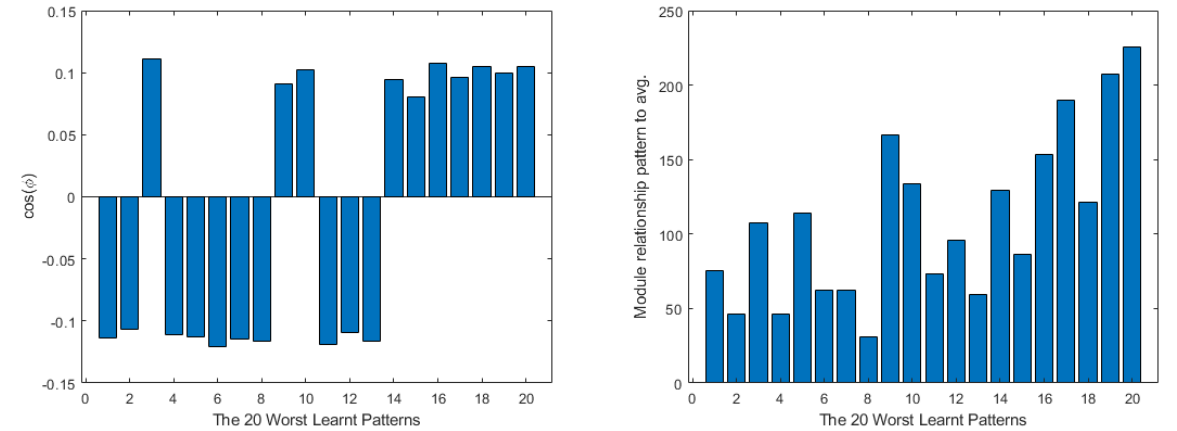
(cid:12) (cid:12) 𝜕𝐿𝑜𝑠𝑠 ∂ Loss (cid:12) (cid:12) | relationship to the average (cid:12) (cid:12) relationship to the average ∂ W n 𝜕𝑊 𝑛